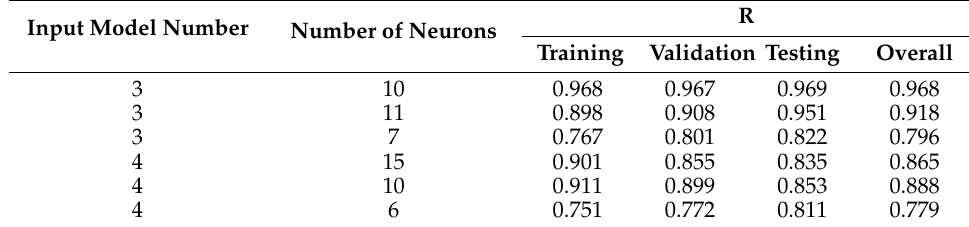
Table 7. Correlation coefficient (R) of ANN network structure